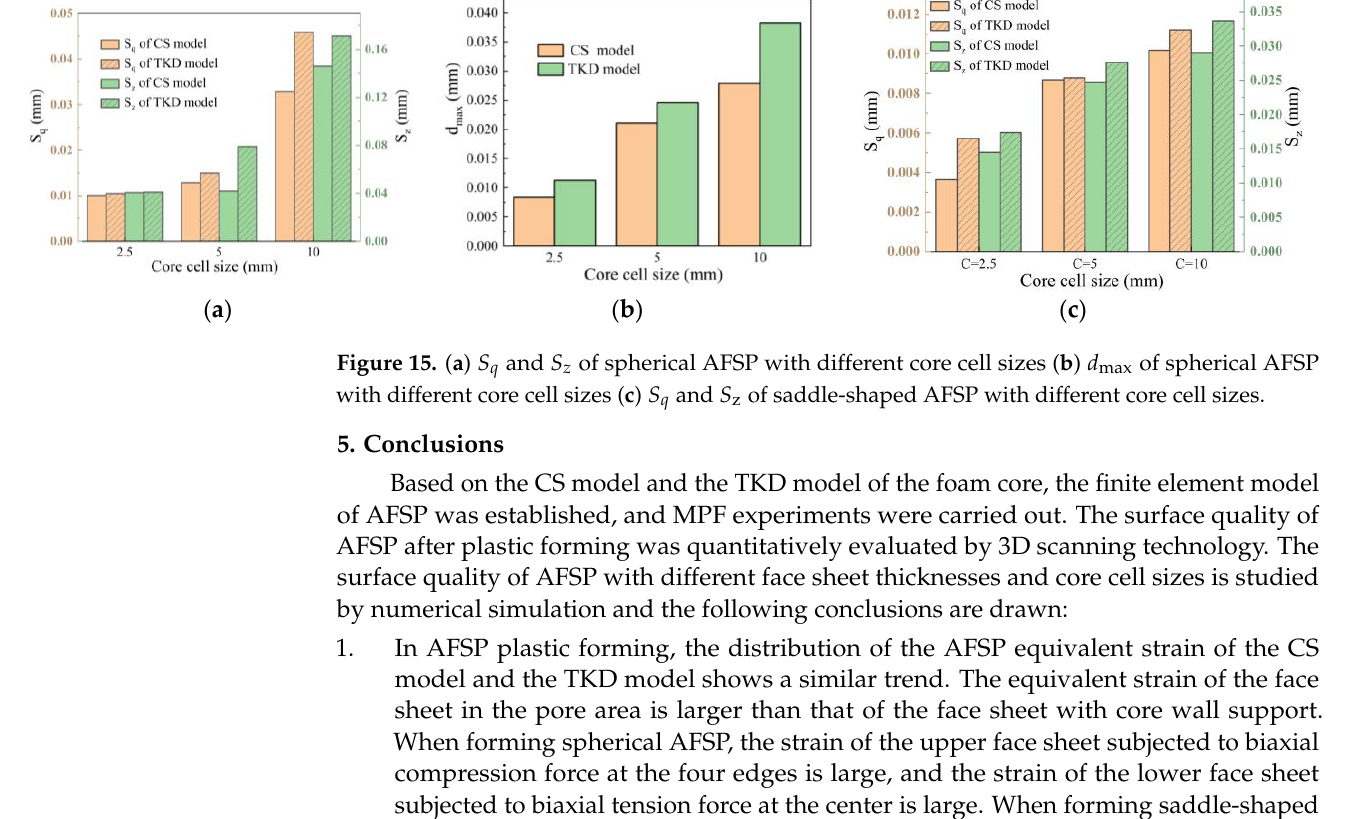
Figure 14. Equivalent strain of spherical AFSP with different core cell sizes.